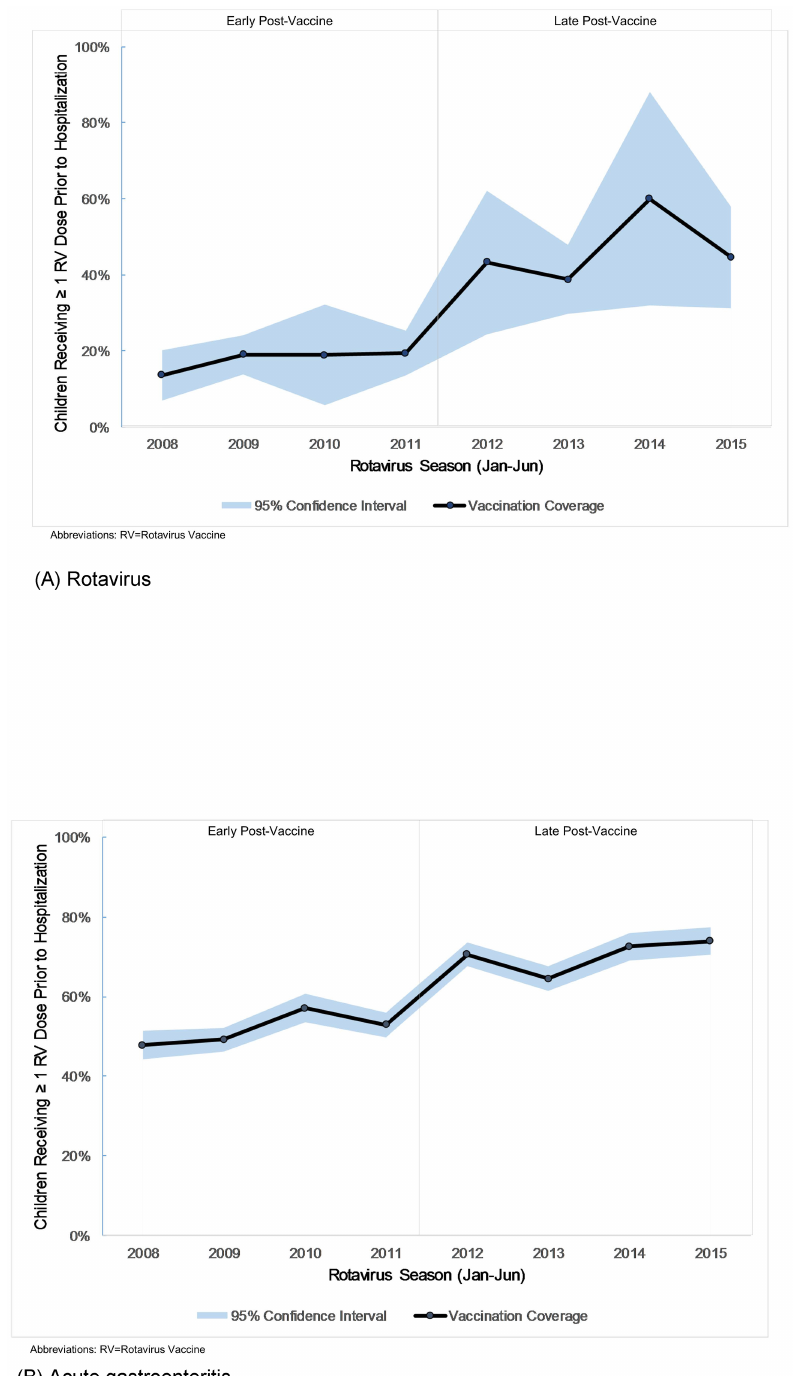
Fig 3. Vaccination coverage for hospitalized children. Percentage of age-eligible children < 60 months receiving at least one rotavirus vaccine dose prior to hospitalization for (A) rotavirus and (B) acute gastroenteritis during rotavirus seasons (Jan-Jun),